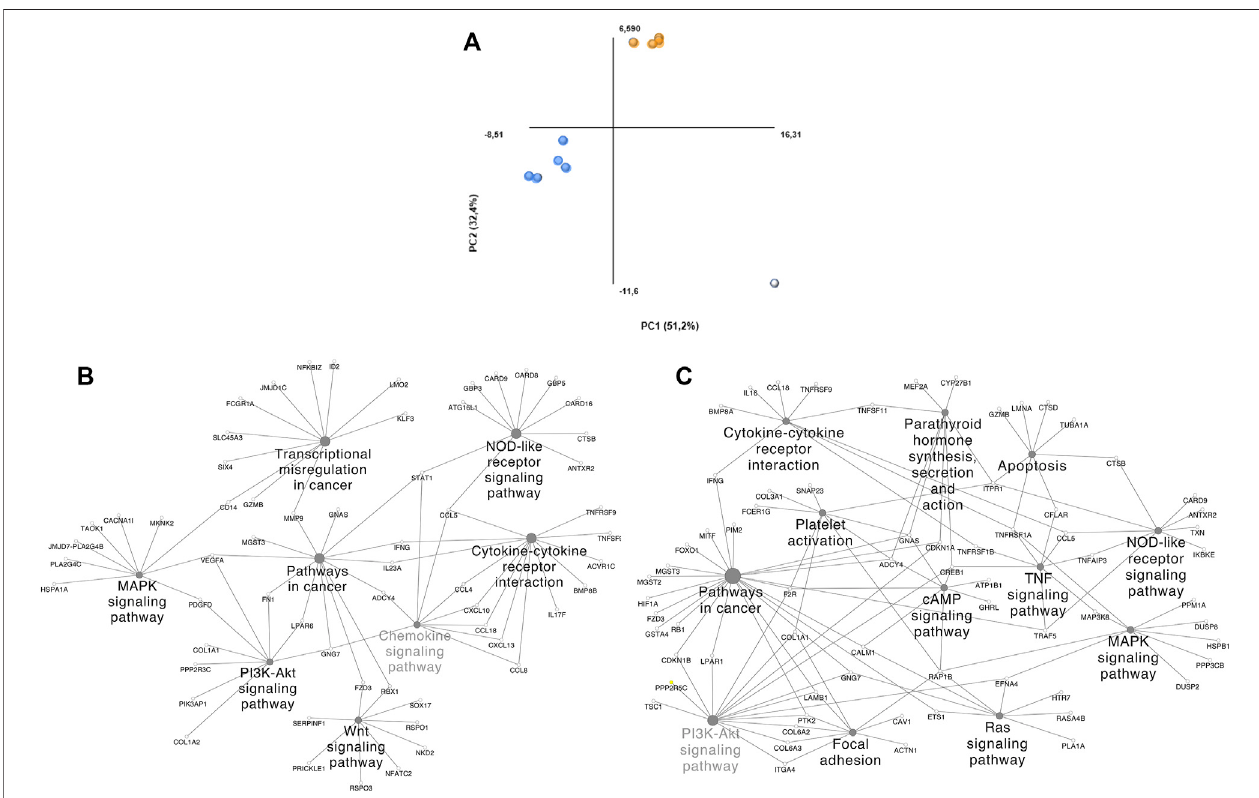
FIGURE 3 | PCA plot grouping and ClueGO/CluePedia focus of our DLBCL cohorts. (A) Blue dots: Group 1; Orange dots: Group 2; White dots: Outliers. (B) ClueGO/CluePedianetworkcreated from theManual approach biomarker list (66% threshold). (C) ClueGO/CluePedia networkcreatedfrom the FSindex Biomarker list (0.75 Absolute FS index threshold).